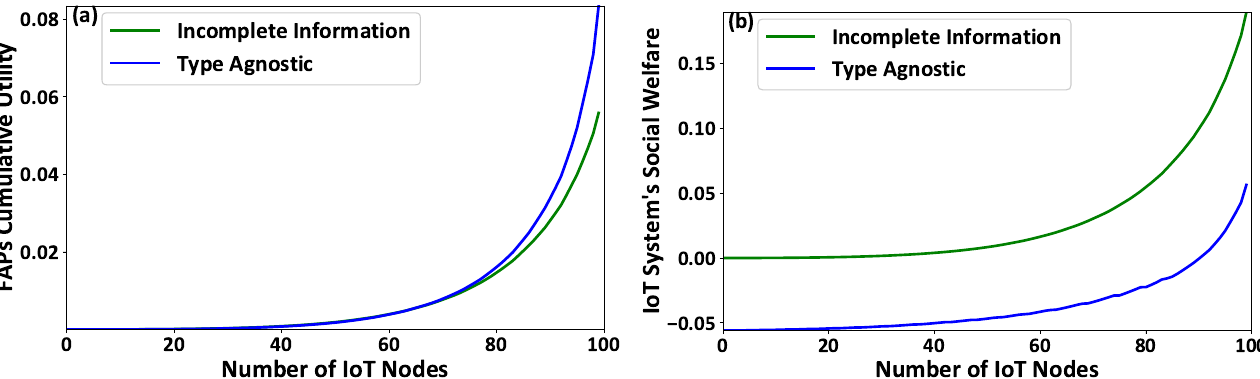
Figure 5. ( a ) FAPs’ cumulative utility and ( b ) the overall IoT system’s social welfare under the contract-theoretic versus the type agnostic framework of energy harvesting.